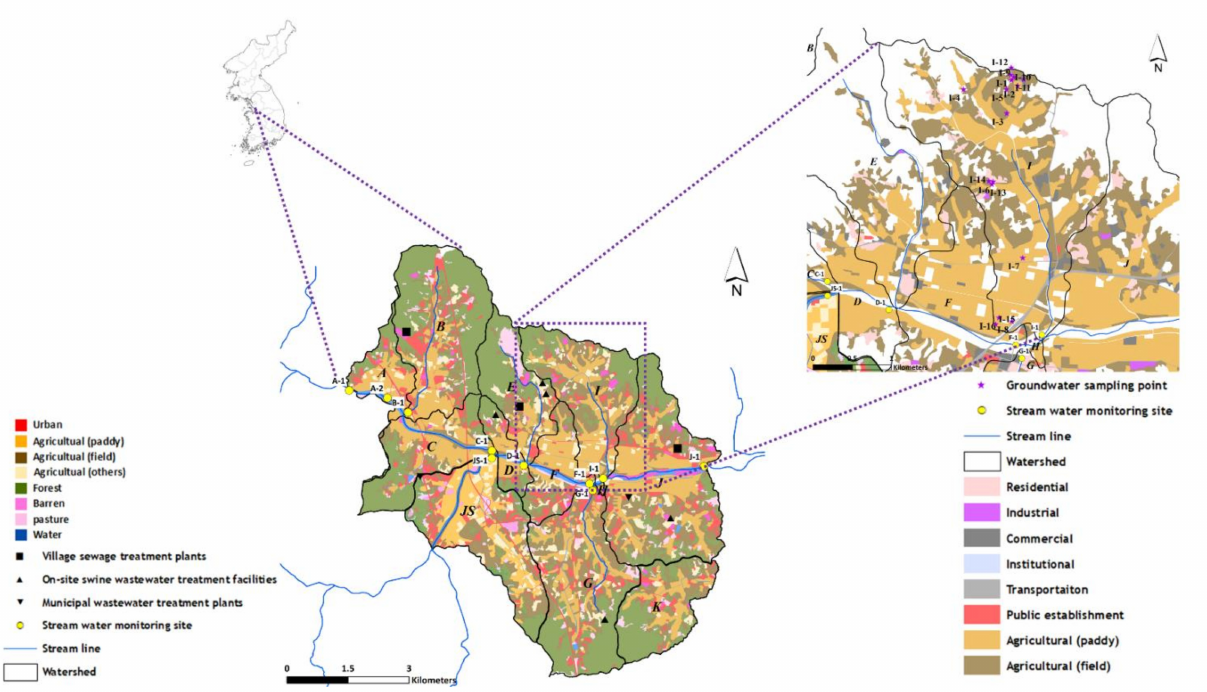
Figure 1. Map showing the sampling points. The alphabet symbols in the watershed map indicate the sampled